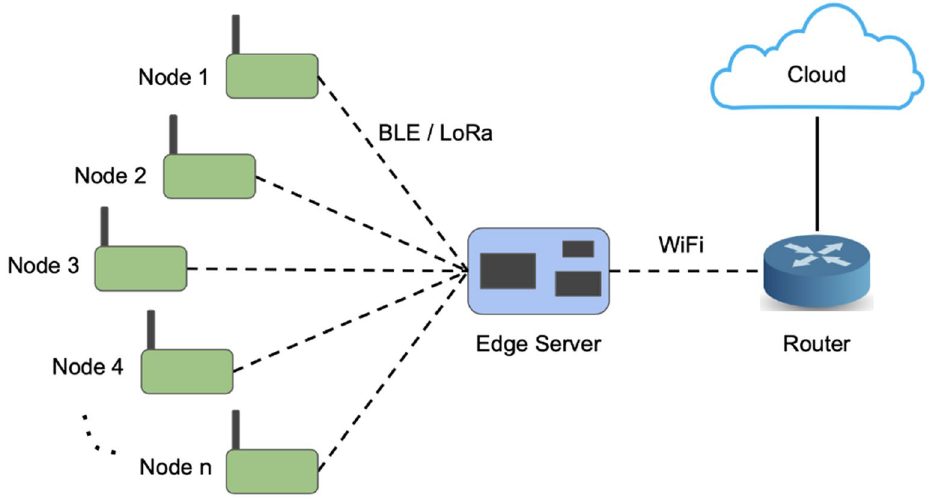
Figure 1. Network architecture.